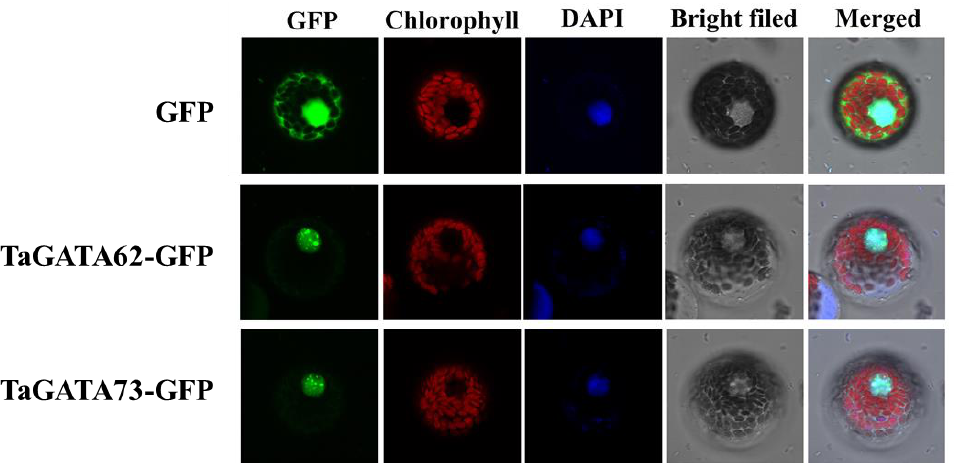
Figure 5. Subcellular localization of TaGATA62 and TaGATA73. Confocal images were captured with Leica SP8 fluorescence confocal microscopy (bar = 10 μm).